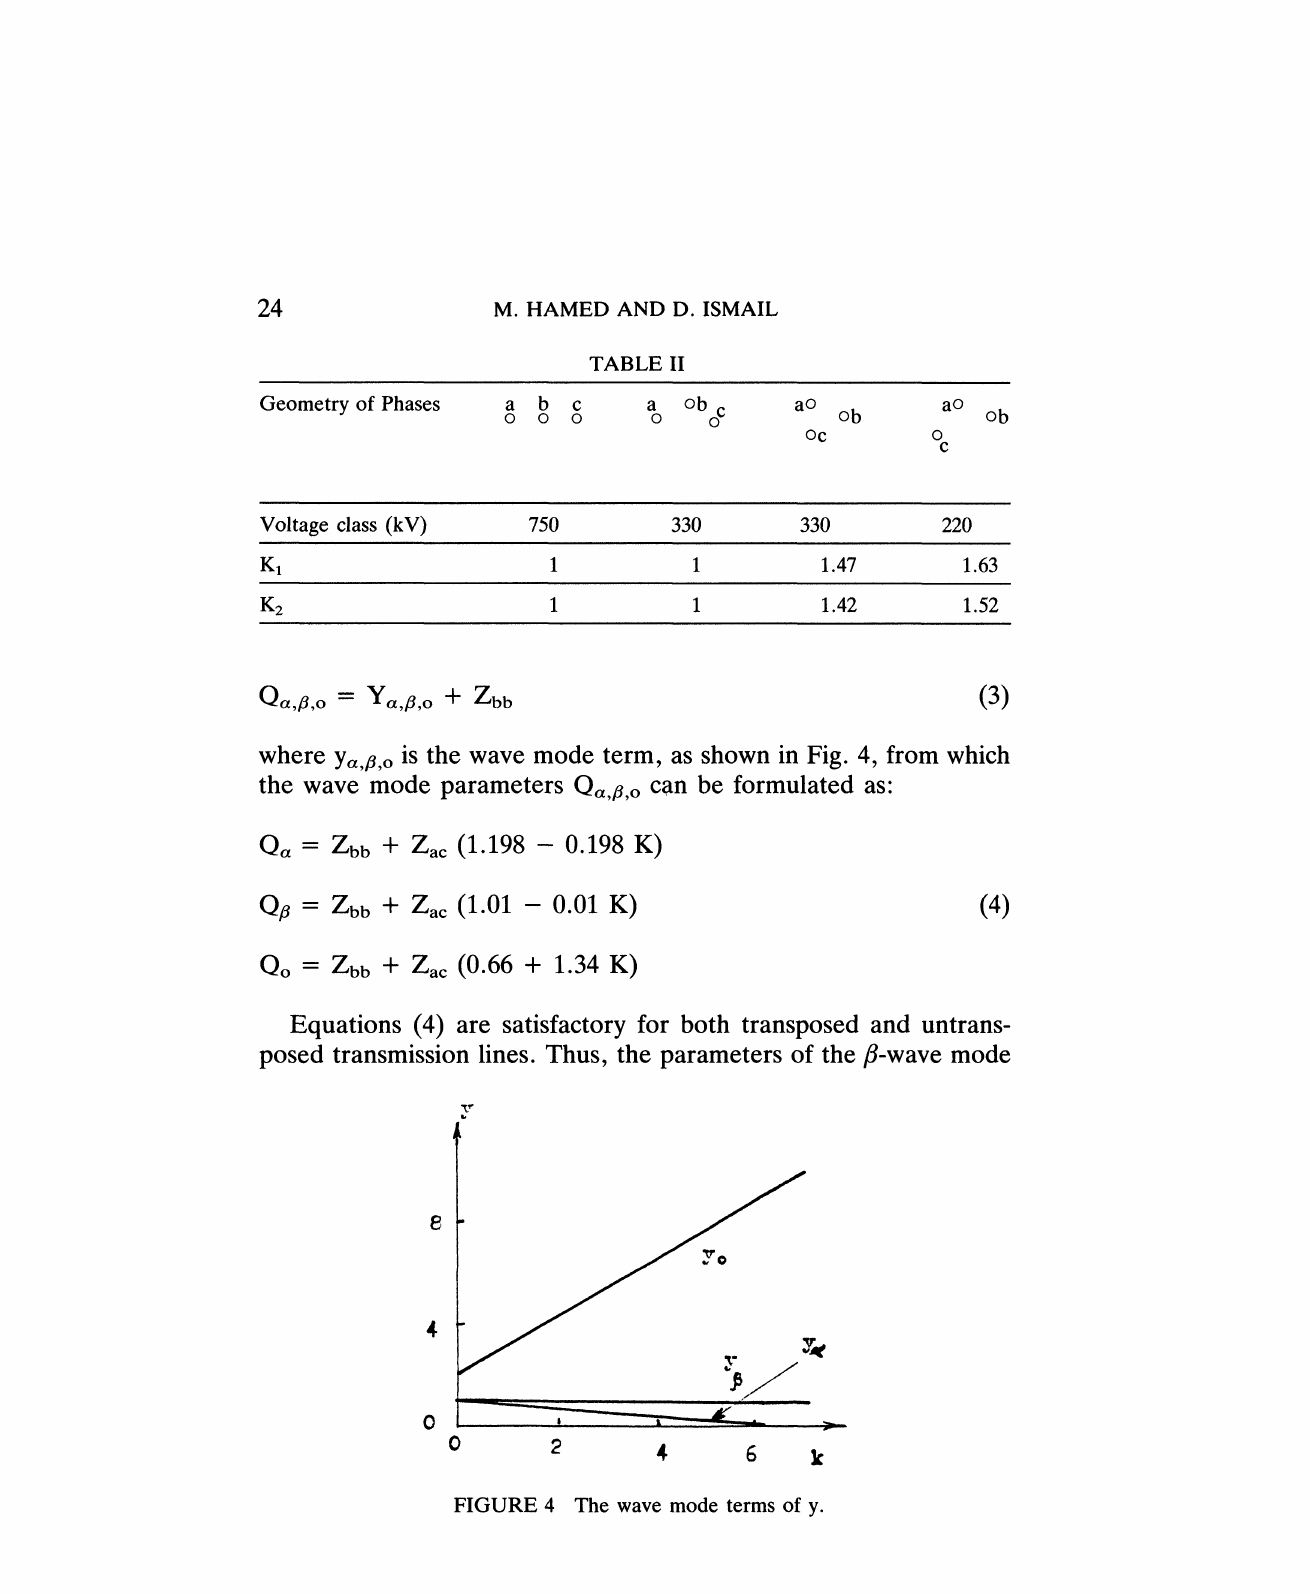
FIGURE 4 The wave mode terms of